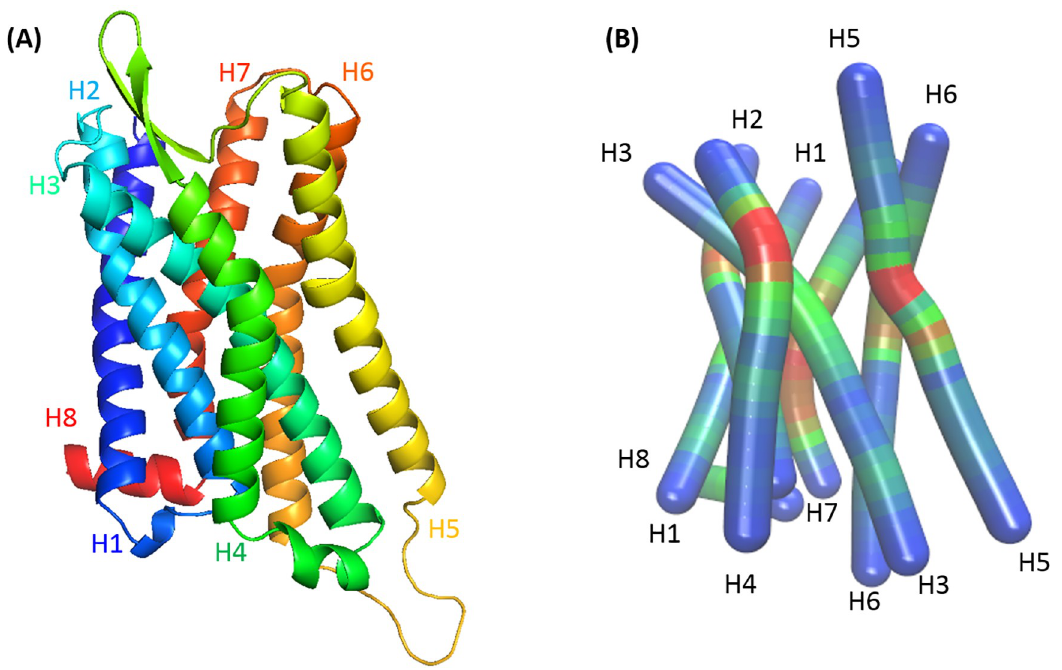
Fig 1. Schematic structure of μ OR. Notations of the 7 transmembrane helices (H1 to H7) and the intracellular helix H8. (A) Ribbon representation. (B) Bendix representation, ranging from blue (no helix tilt) to red (maximum helix tilt).